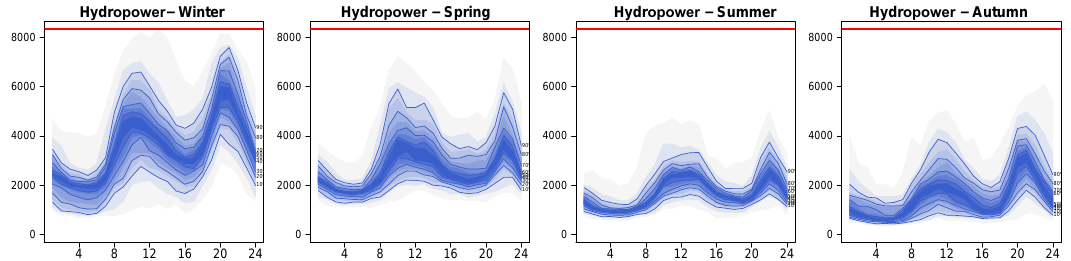
Figure 5. The hydropower seasonal generation pattern for 2017. Source: authors based on the data from REE [11].